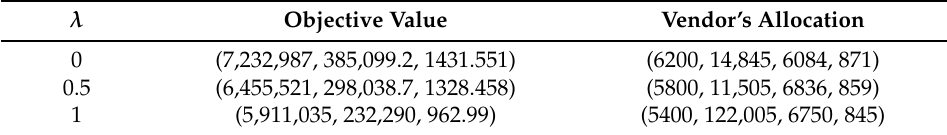
Table 8. Compromise objective value and allocation for case 1 with fixed demand.